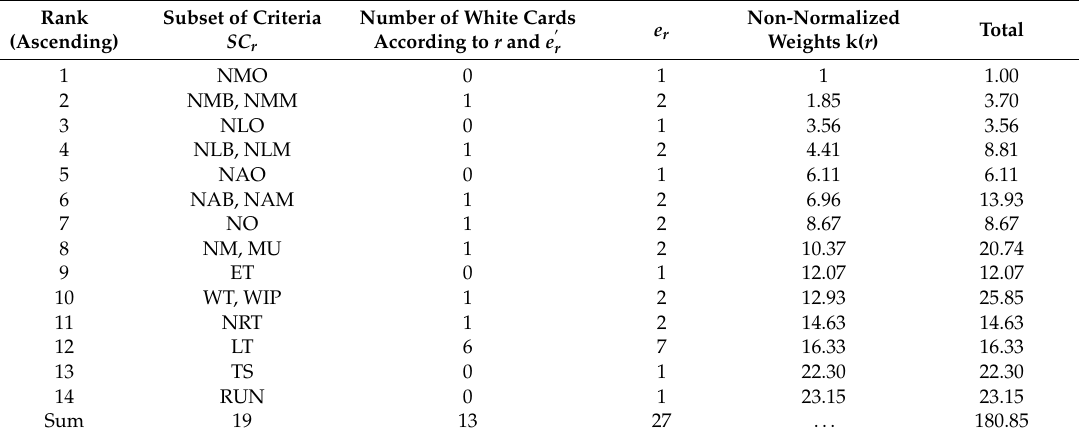
Table 7. Non-normalized weights for z = 24.